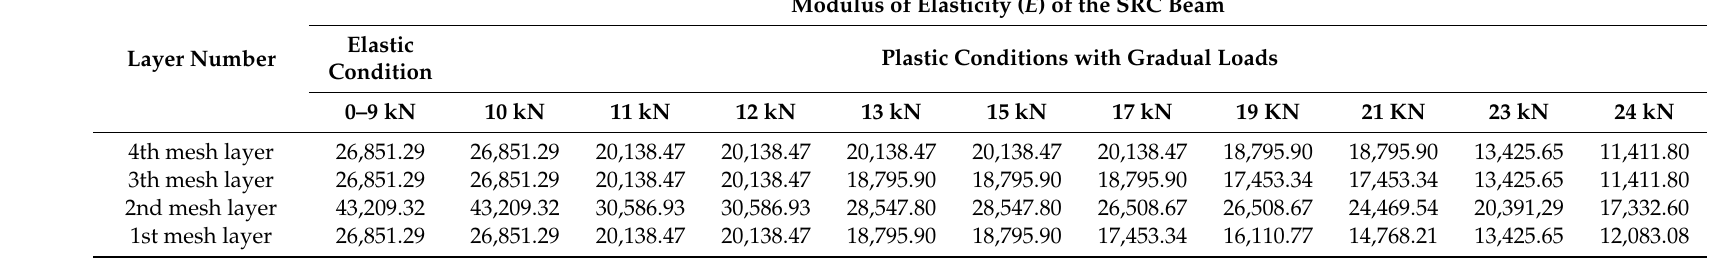
Table 8. The modulus of elasticity for each layer of the SRC beam in the non-linear